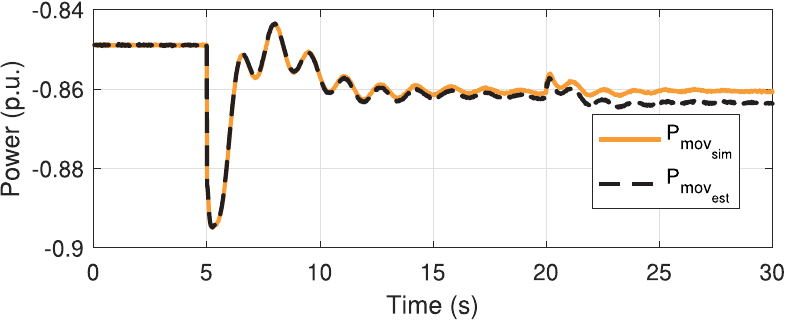
Figure 13. Moving powerestimated (Area 2).